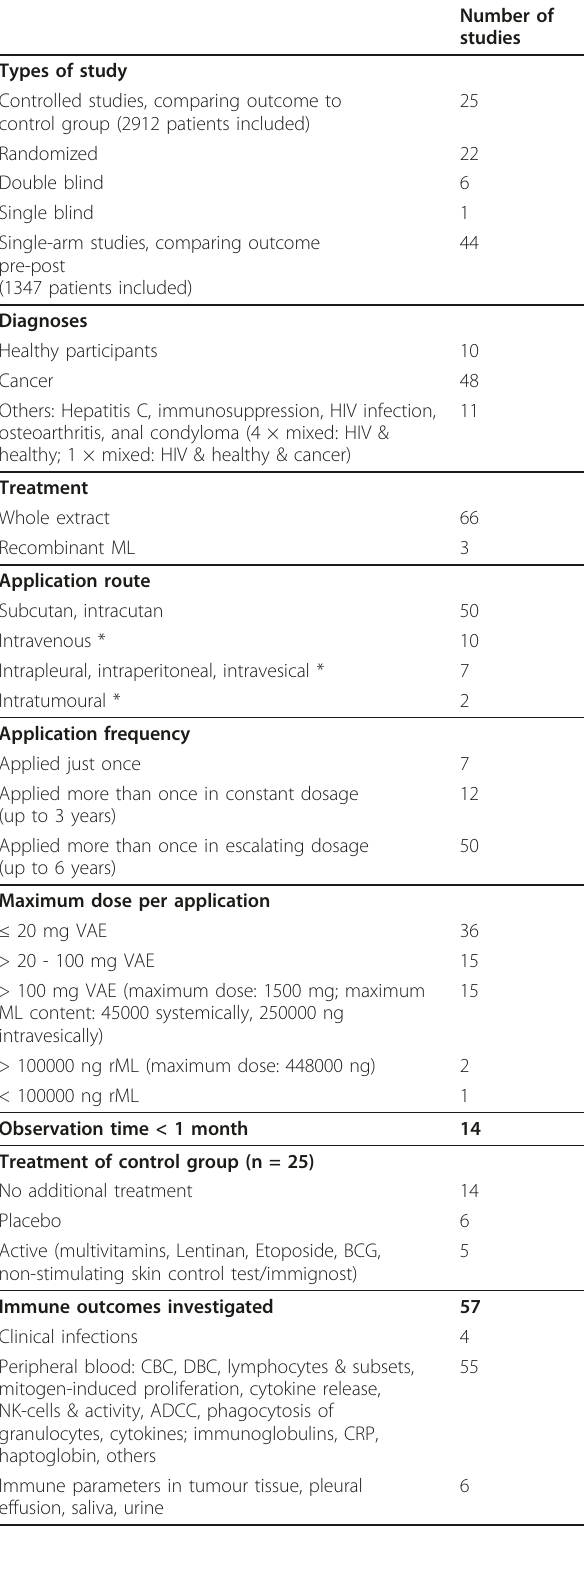
Table 2 Characteristics of the clinical studies (n = 69)